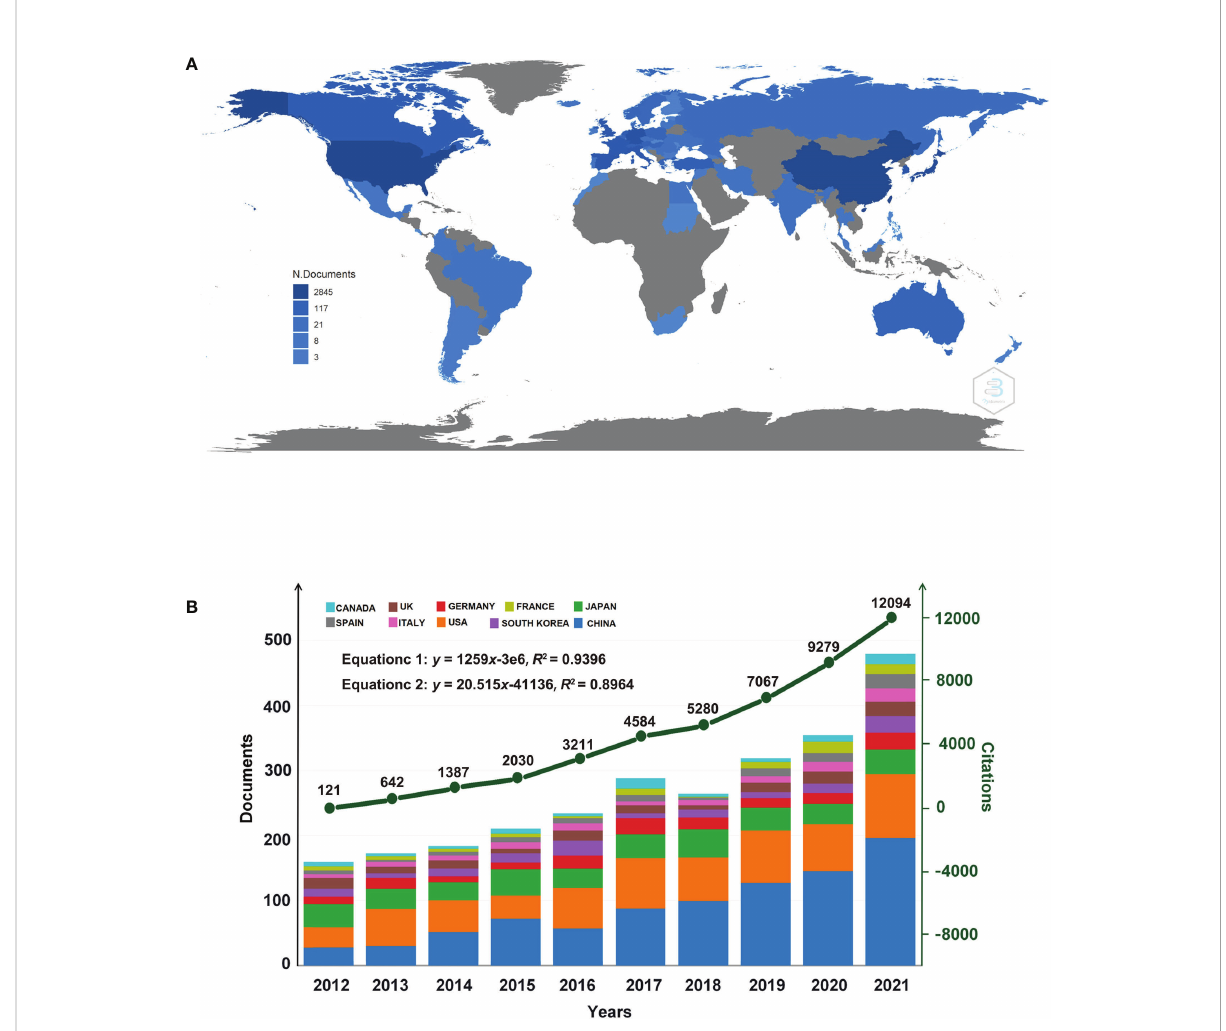
FIGURE 2 (A) Geographical distribution of global articles of SCLC. The darker the national color block on the map, the more SCLC-related articles are published. (B) Dynamics of publications and total citations in the top 10 countries in the past 20 years. The number of articles and citations was on the rise. Equation 1 can predict the annual citations, while Equation 2 can predict the annual